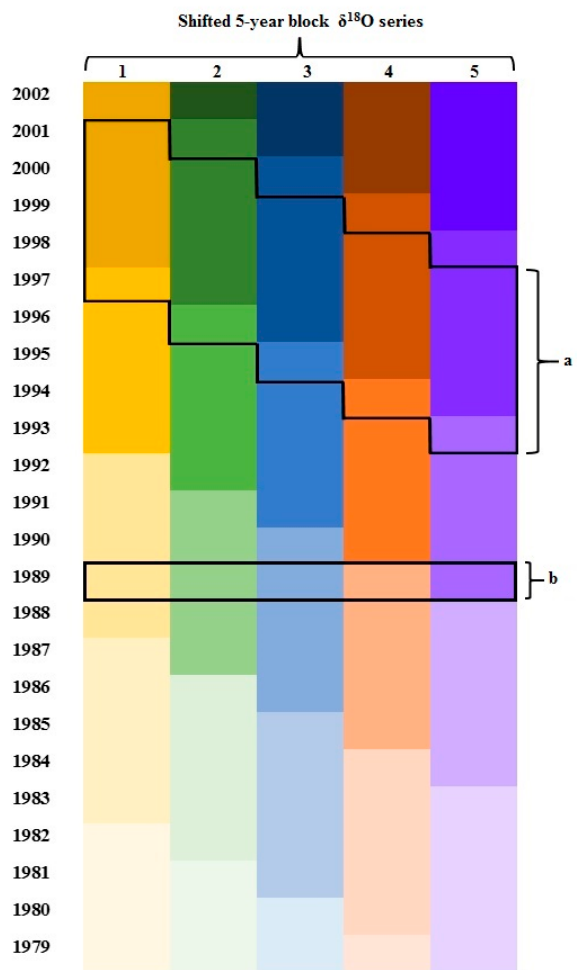
Figure 3. Schematic illustration of averaging the δ 18 O series of shifted 5-year blocks (SBP): ( a ) shows averaging annual δ 18 O values for the year 1997 in the chronology built by a 5-year running mean calculation of the δ 18 O values (SBP r ) and ( b ) mean annual δ 18 O values for the year 1989 in the chronology built by arithmetic averaging of individual tree-ring δ 18 O values of the δ 18 O series (SBP a ). Each color displays one pentad block.